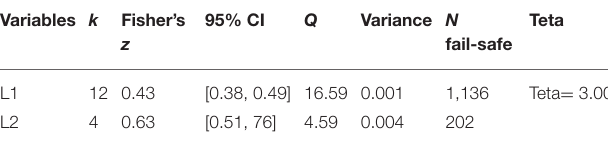
TABLE 3 | Language type comparison on MS–reading